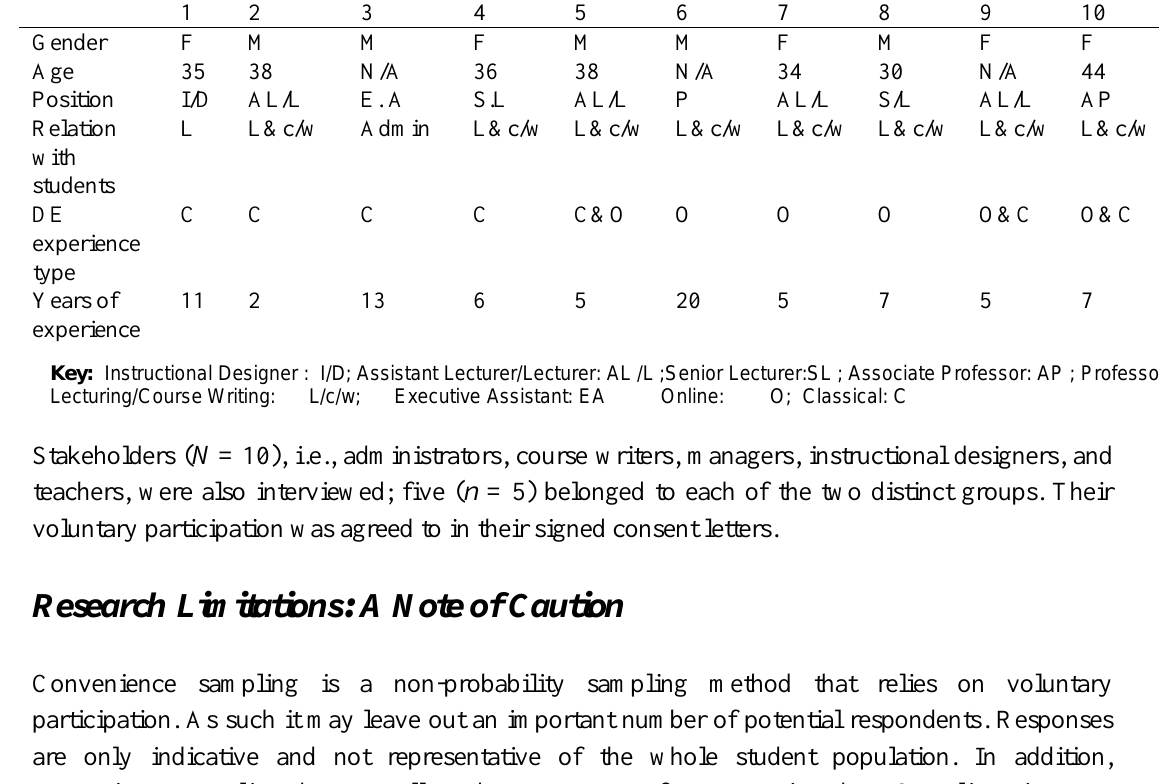
Table 2 Profile of